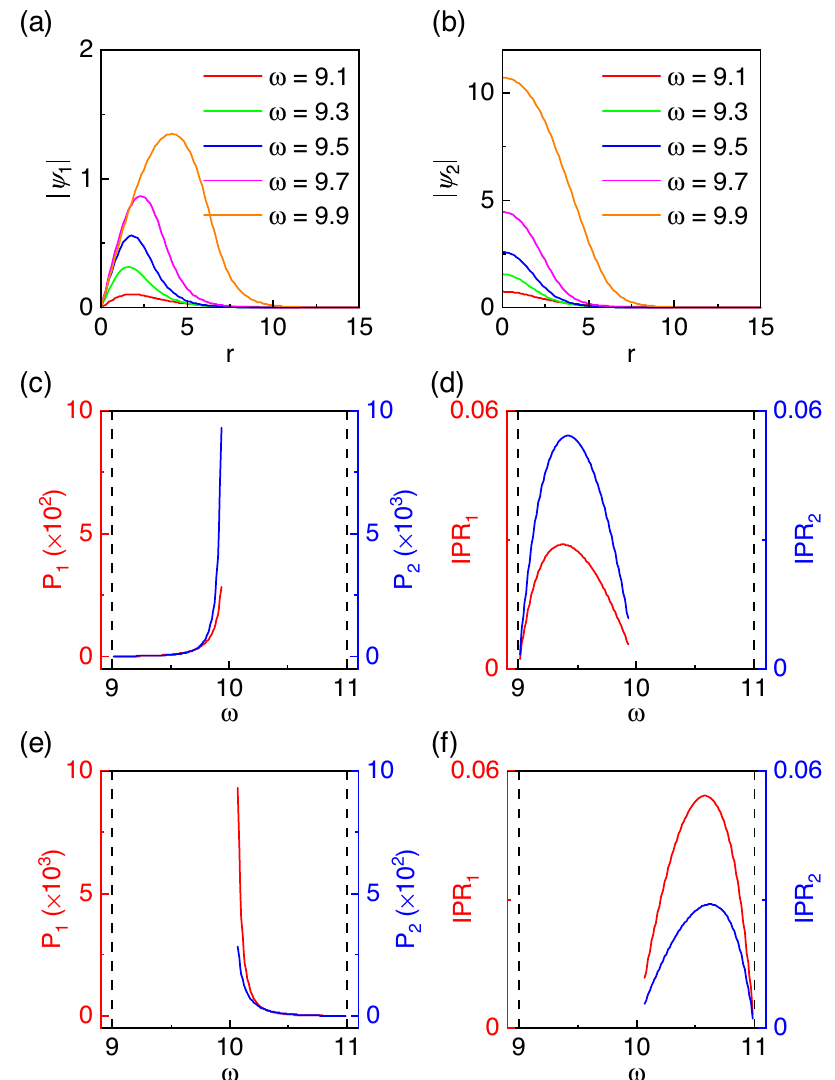
Fig. 4 Radial distributions and existence curves of the bulk solitons. a , b The radial distributions of the bulk solitons under the self-focusing nonlinearity with g = 1. Power ( c ) and inverse participation ratio (IPR) ( d ) of the bulk soliton under the self-focusing nonlinearity with g = 1. Power ( e ) and IPR ( f ) of the bulk soliton under the self-defocusing nonlinearity with g = − 1. The dashed lines in c – f denote the lower and upper band